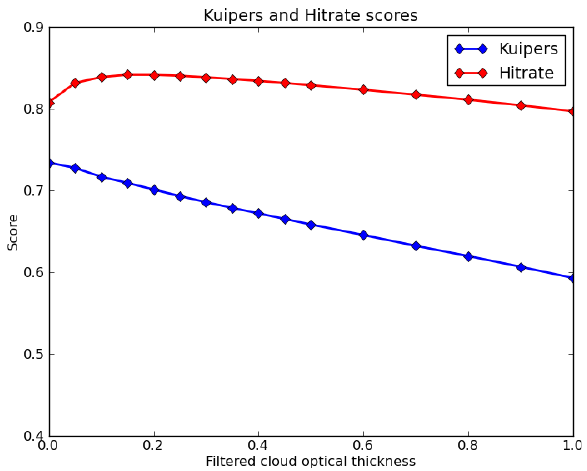
Fig. 9. Same as Fig. 6 but after treating CLARA-A1/PPS misclassi- fied clear pixels as truly clear and not as cloudy (see motivation in text).